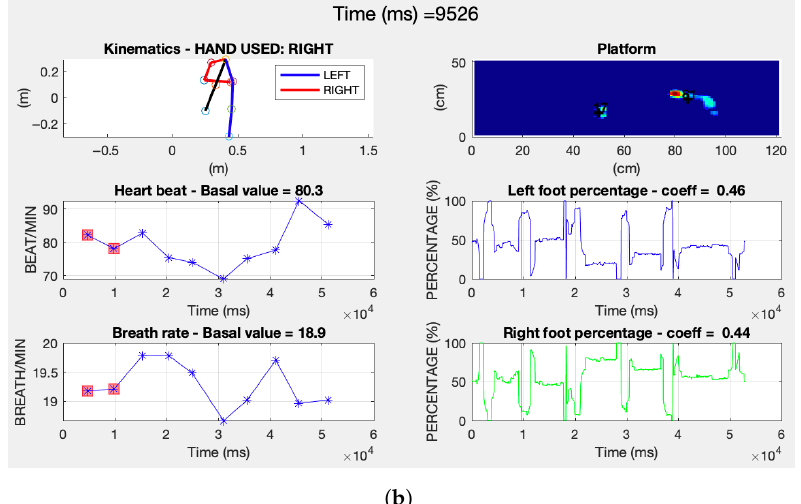
Figure 19. ( a ) Image with therapist and tester data, all errors in object placement and time of execution; ( b ) all other tester parameters are summarized in this second